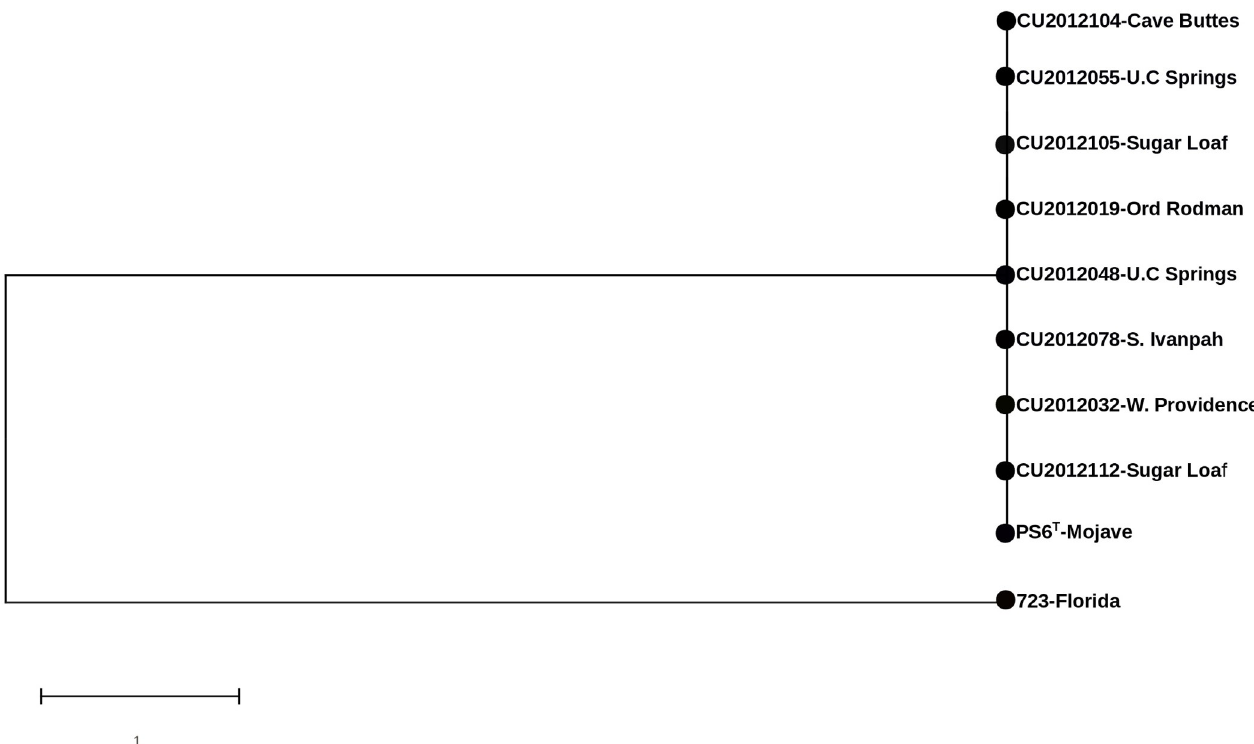
Fig 2. Maximum likelihood phylogenetic tree of Mycoplasma agassizii from eight samples with low to high coverage and the PS6 T and 723 strains based on 1373 SNPs.